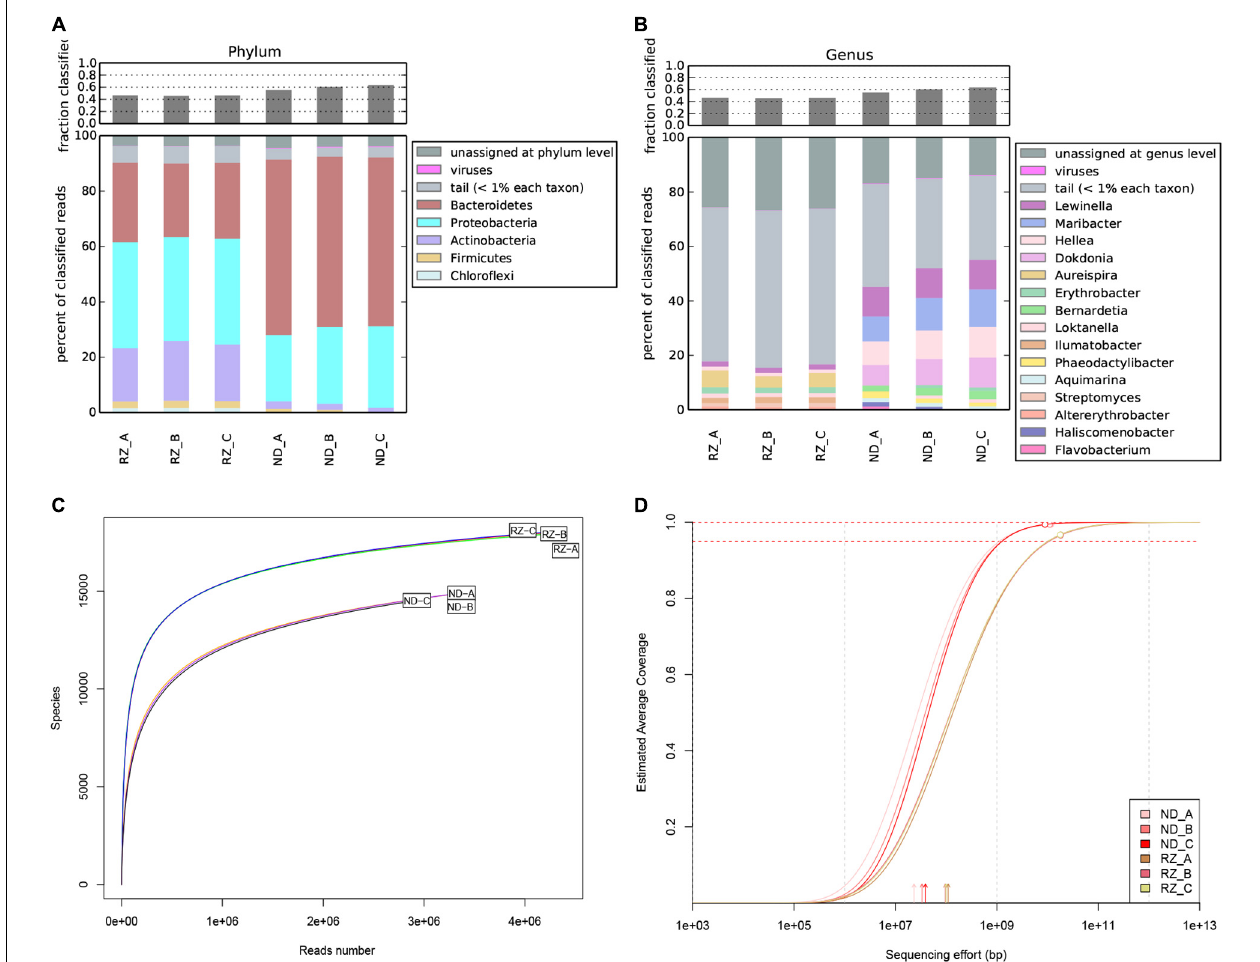
FIGURE 1 | Taxonomic profiling, Rarefaction curves and Non-pareil curves of the Pyropia haitanensis microbial dataset. Microbial community structures of P. haitanensis at the phylum (A) and genus (B) level based on non-redundant NCBI BLAST database. Phyla/Genera in different colors are shown in the legend. Categories with relative abundance lower than 1% are merged and defined as “tails”. Reads that are not assigned to any of the above levels are defined as “unassigned at phylum/genus level”. Rarefaction curves (C) and Non-pareil curves (D) showing estimated average coverage in metagenomic datasets. The empty circles (D) indicate the size and estimated current average coverage of the samples. RZ, Rizhao; ND,